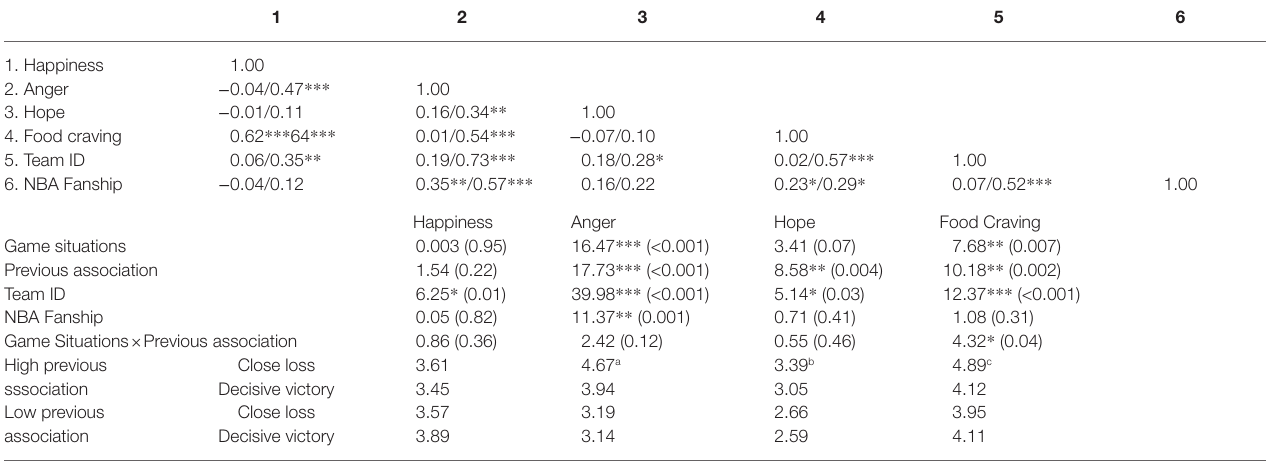
TABLE 2 | Correlation coefficients (low/high previous association), F-statistics (Sig.), and LSMs. 1